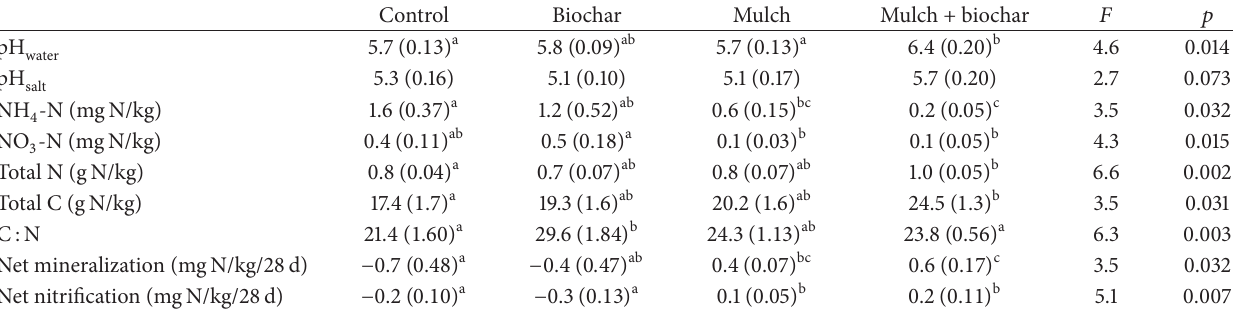
Table 1: Soil properties and net N incubations 3 years after establishment of rehabilitation treatments at the Church’s Park fire, Colorado. Treatments include lodgepole pine-derived biochar and wood chip mulch, their combination, and untreated, severely burned soils. Data are means and standard error in parentheses ( 𝑛 = 6 blocks of 5 × 5 m study plots).